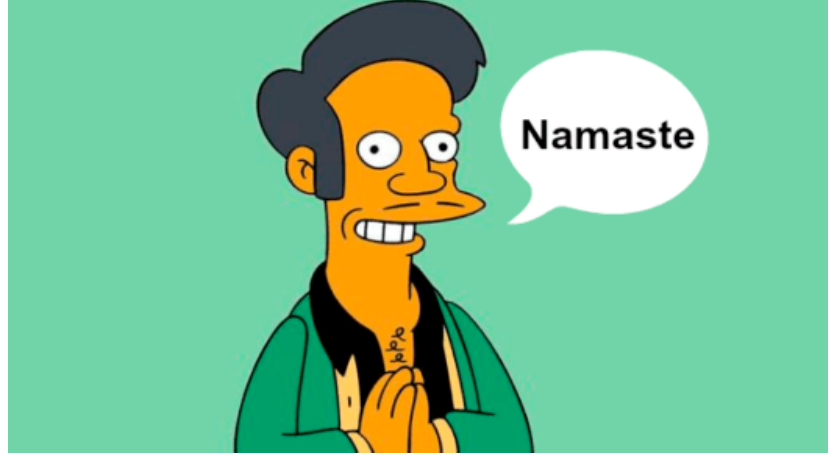
Figure 6. The Simpsons Dr. Apu Nahasapeemapetilon. Photo source: Fox.